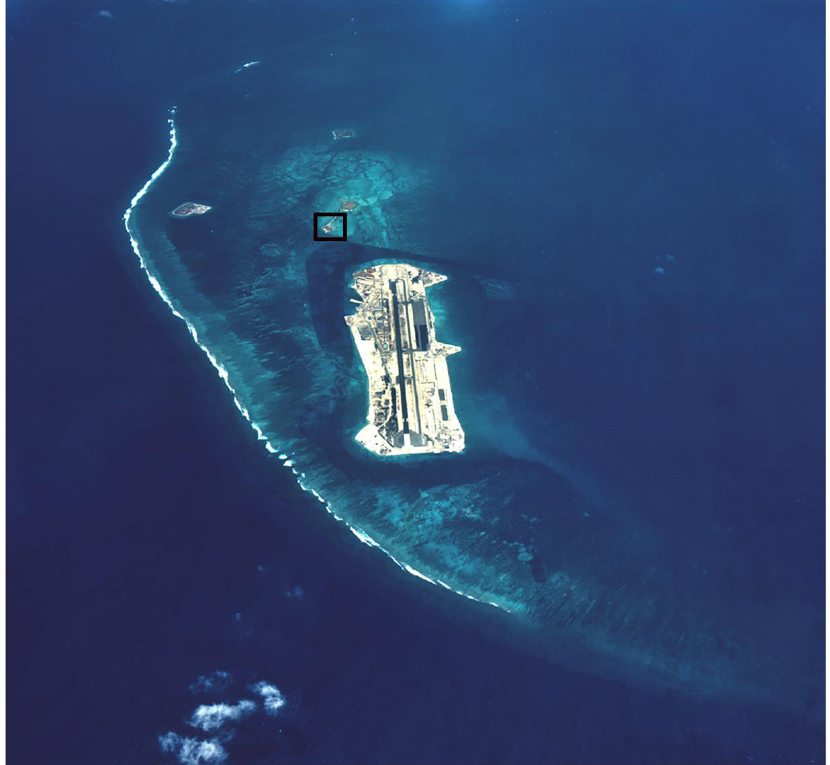
Figure 2. Aerial view of Johnston Atoll looking east. Johnston Island is the largest, with East Island the farthest to the east of Johnston, and North Island to the left or north of Johnston. The black box surrounds the study location at the west end of Sand Island.